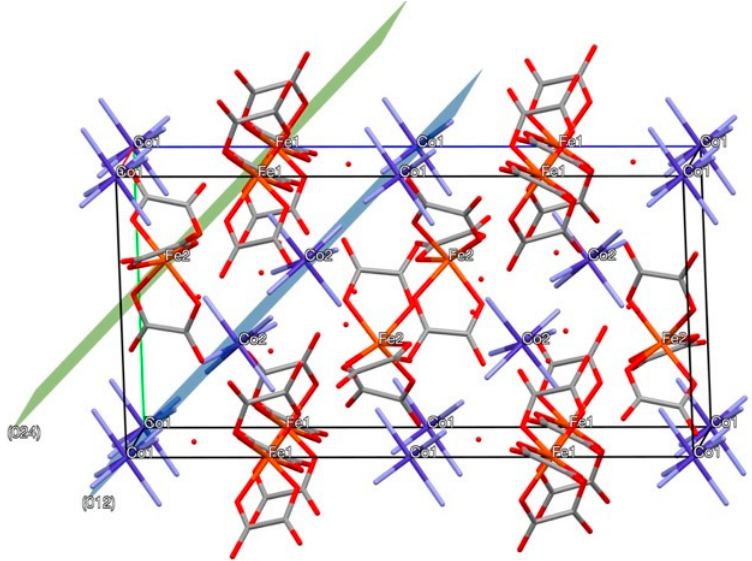
Figure 1. General view of the unit cell in the crystal structure of [Co(NH 3 ) 6 ][Fe(C 2 O 4 ) 3 ] · 3H 2 O along the hexagonal axis a . Crystallographic planes (0 1 2) and (0 2 4) correspond to [Co(NH 3 ) 6 ] 3+ and [Fe(C 2 O 4 ) 3 ] 3 − · hexagonal layers.